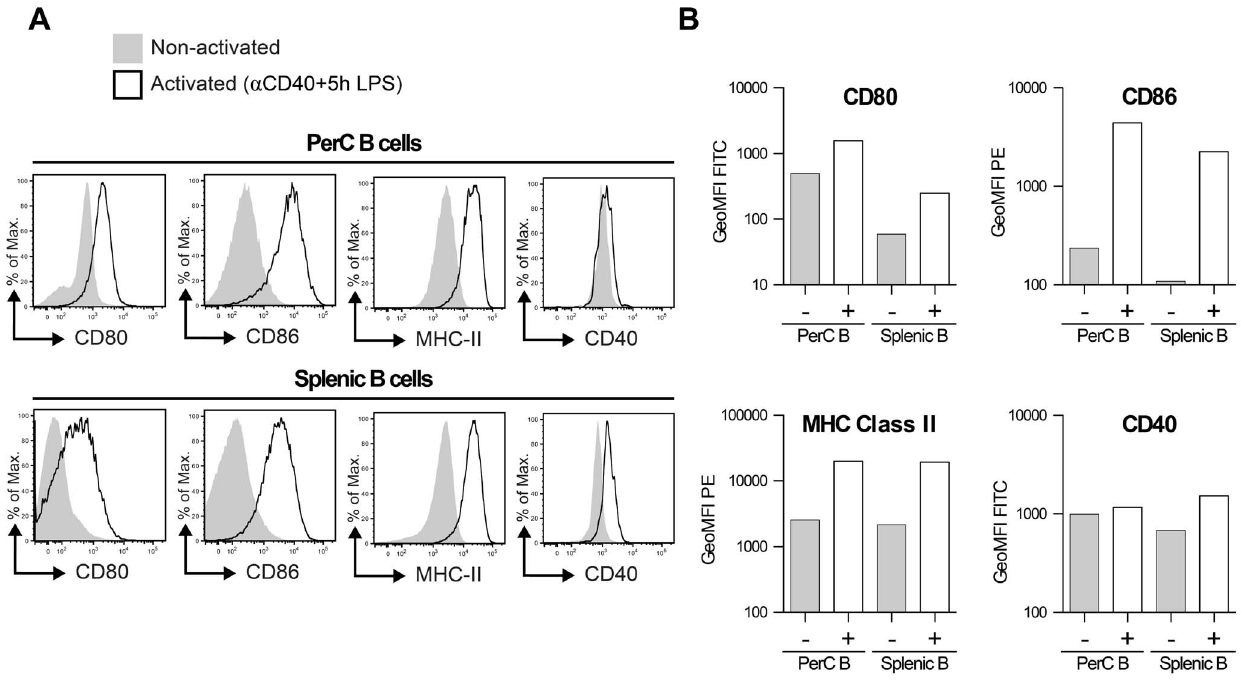
Figure 3. PerC– and Splenic B cells possess different surface markers after activation. Indicated B cell populations were stained extracellular with mAbs against CD19 and indicated markers after both a 48 h period of stimulation using a CD40 + 5 hr LPS ( + : activated; see materials and methods) and after being isolated freshly (–: non-activated). Shown in A are expression levels of indicated markers on CD19 + B cells (representative plots of two identical replicate experiments), in B the average geometric mean fluorescence intensity (GeoMFI) levels from two identical replicate experiments.